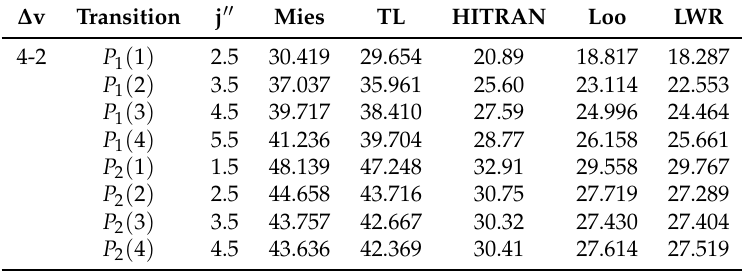
Table 2. Table of Einstein A coefficients for the P branch of OH ( 4 − 2 ) . The Einstein A coefficients have units of s − 1 and are from Mies [6], Turnbull and Lowe [8], Rothman et al. [17], van der Loo and Groenenboom [16], and Langhoff [7] with these coefficients being labeled Mies, TL, HITRAN, Loo, and LWR